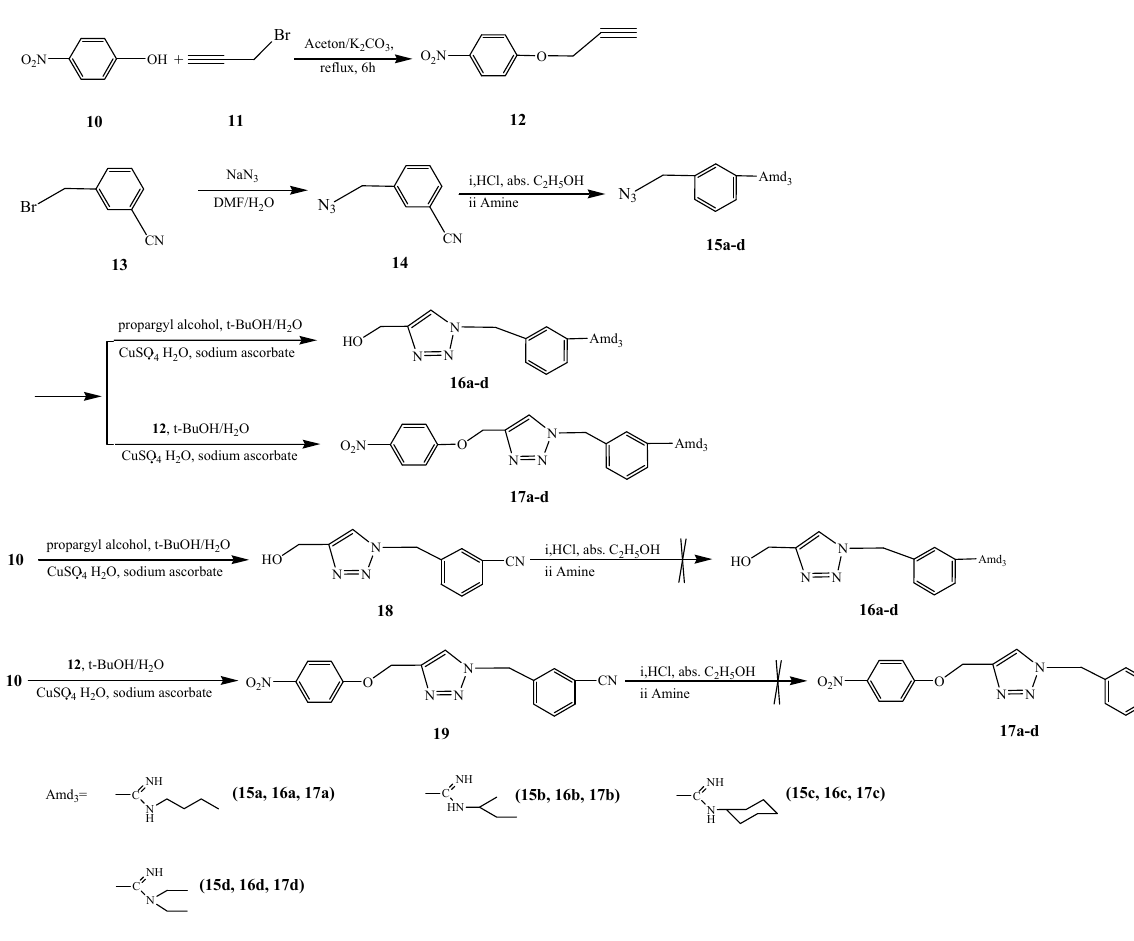
Table 1. Inhibition activity (%) of the amidines on phytopathogenic fungi a .